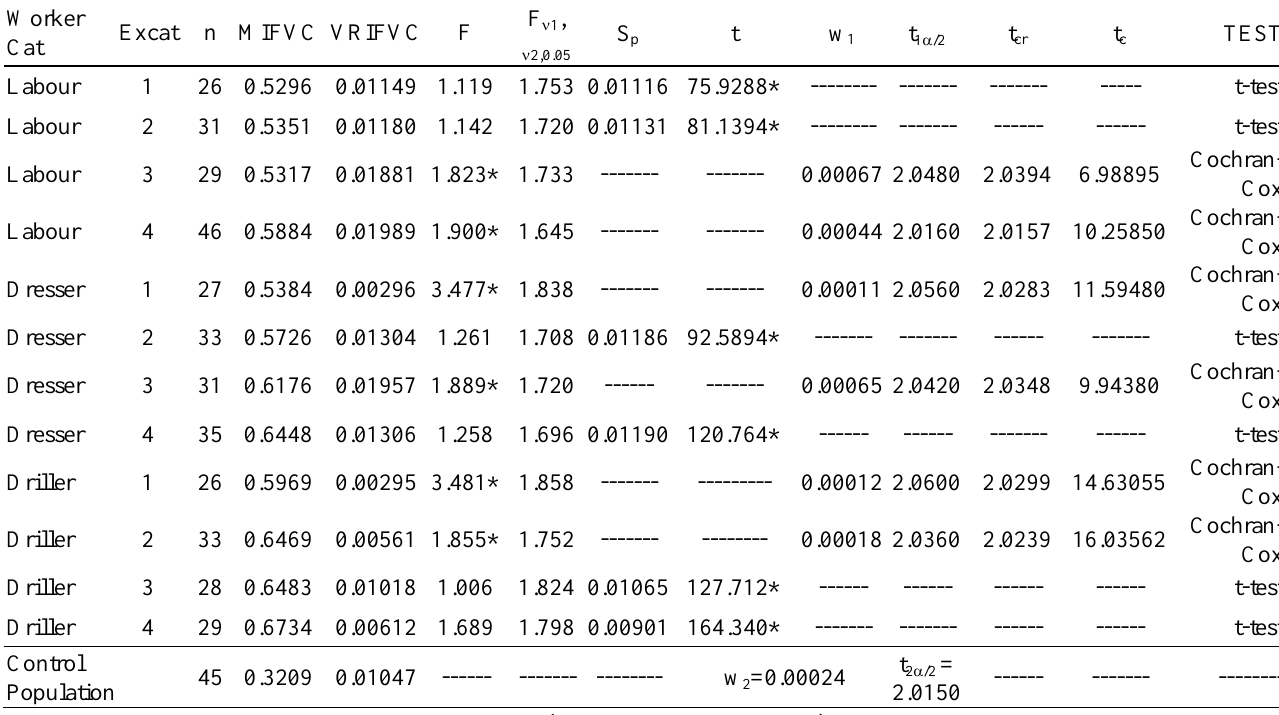
Table 6: Tests for equality of means of exposed and control population for